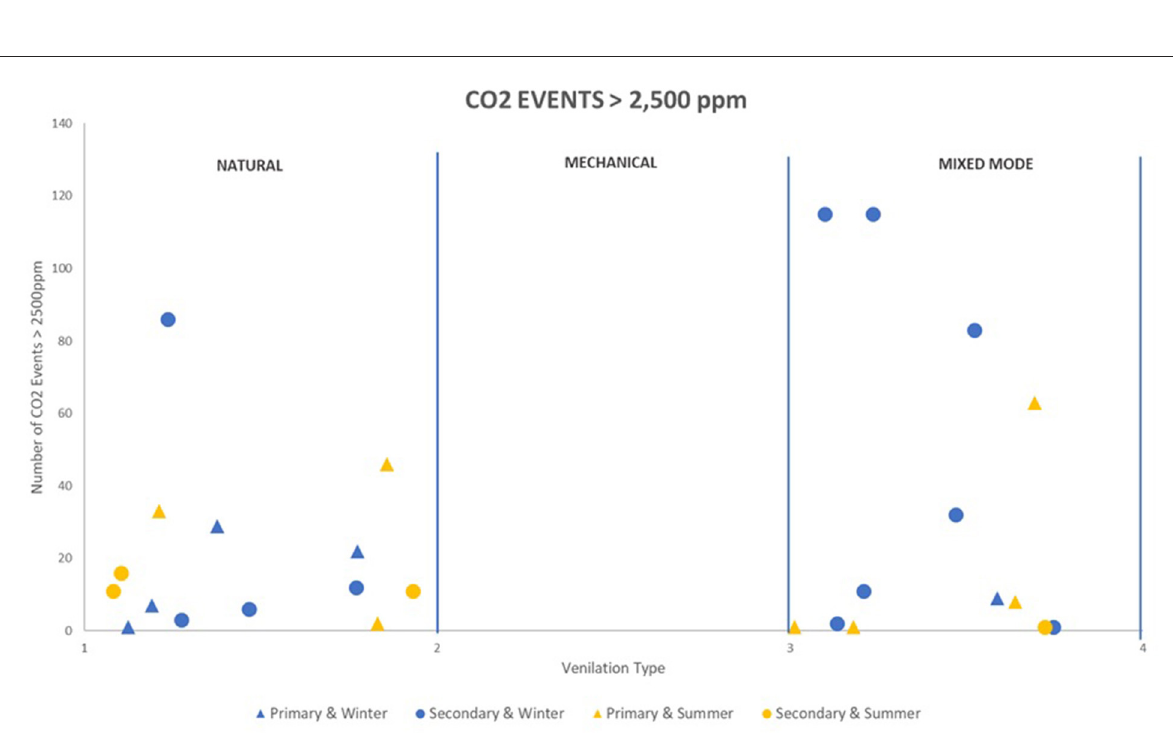
FIGURE5 Incidence of > 2,500 ppm exceedances with ventilation type, primary/secondary classroom type and the season which the monitoring was conducted. Winter: 01 May − 31 August, Summer: all other times of the